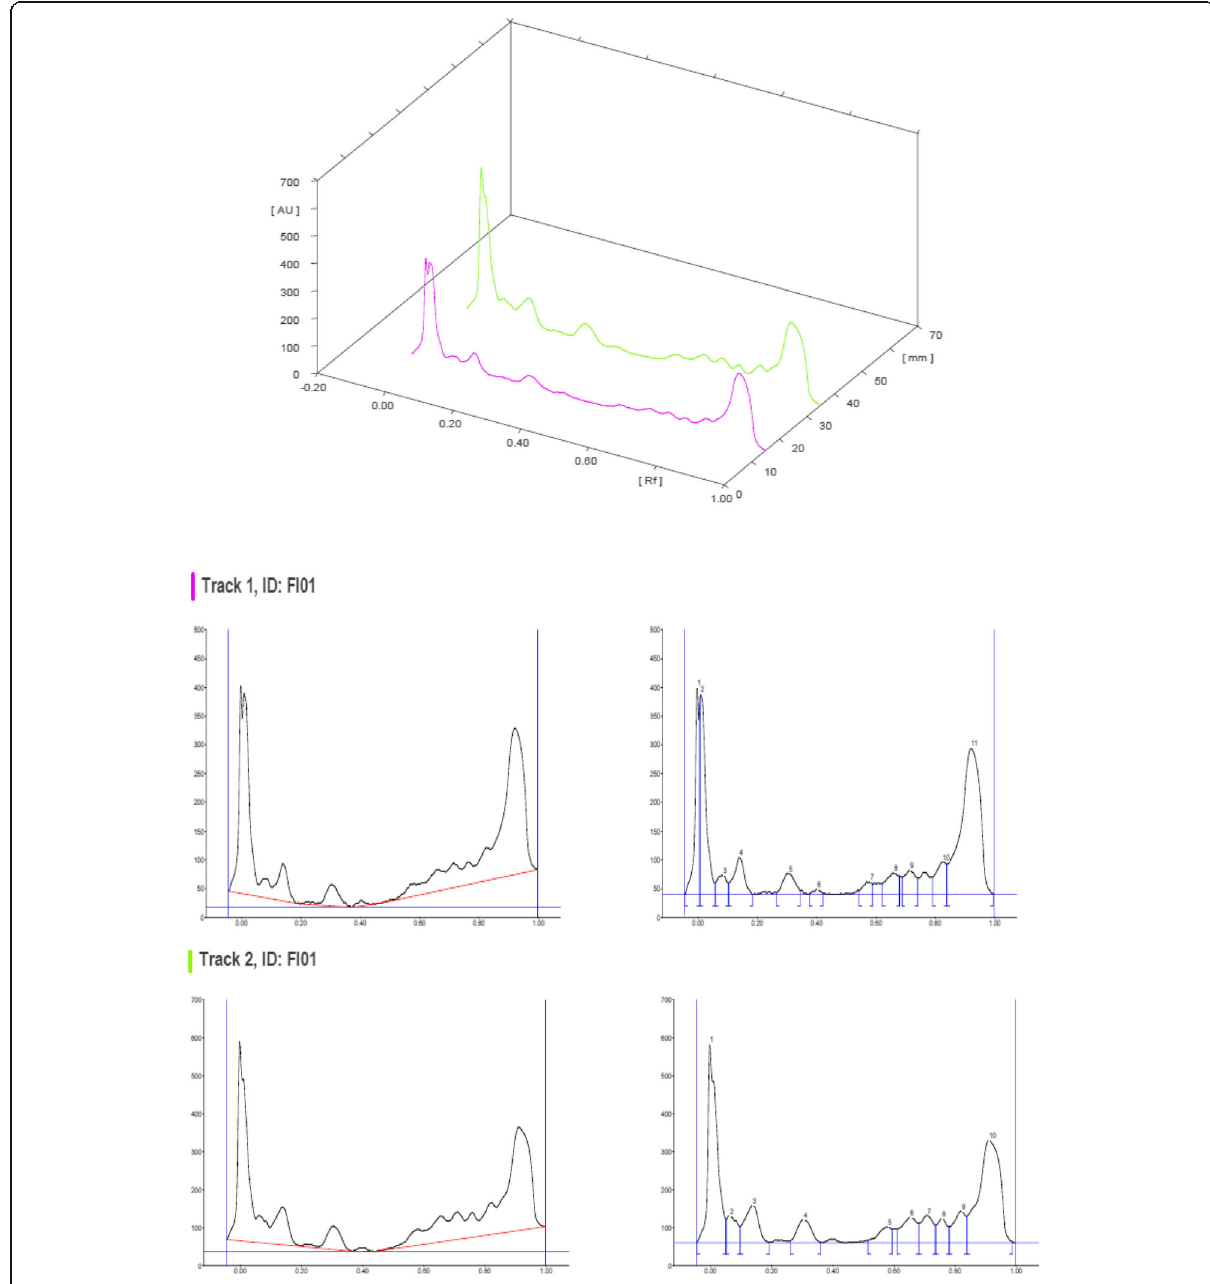
Fig. 2 HPTLC chromatograms scanned at 254